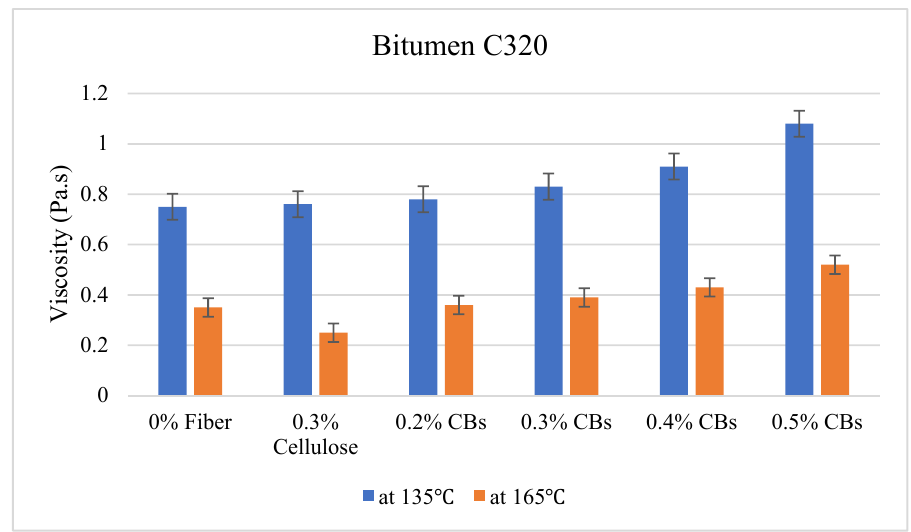
Figure 11. Comparative viscosity of Bitumen C320 modified with different types of fiber.